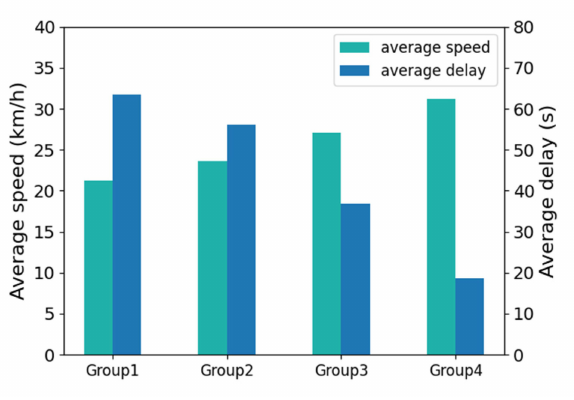
Figure 6. Histogram of V on − street and D on − street in four scenarios of c ∗ . Table 5. Descriptive statistical results of the speed and delay on road traffic flow in four scenarios of c ∗